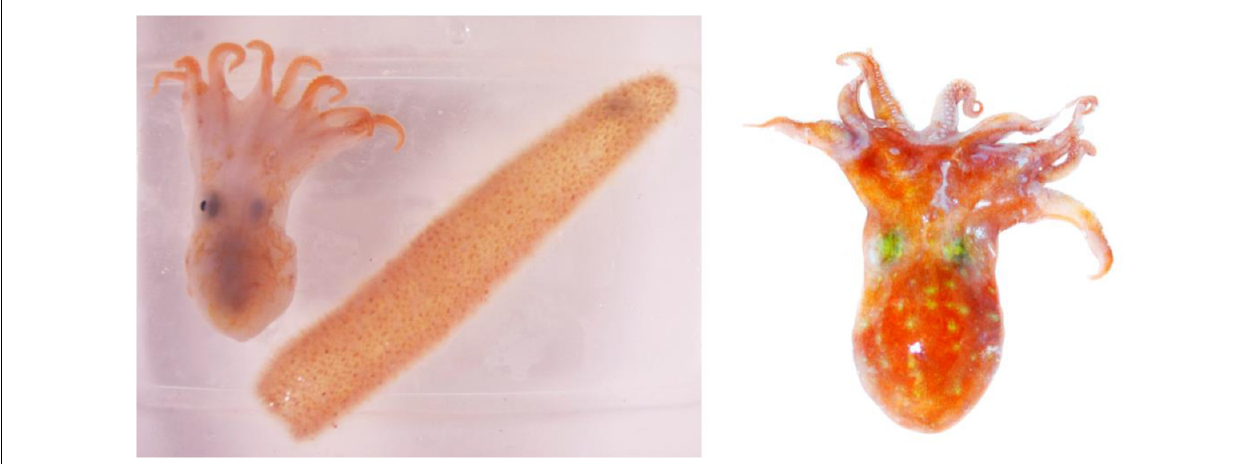
Atlantic. Photo from Vladimir Laptikhovsky